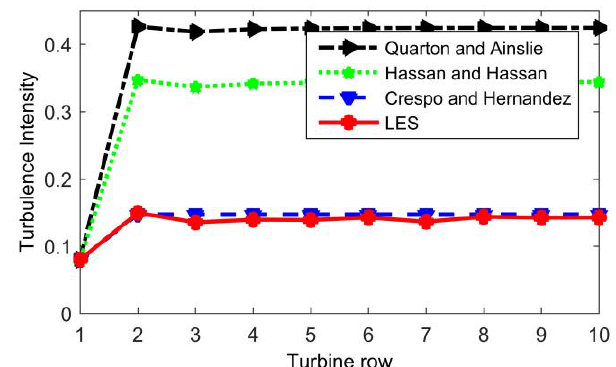
Figure 10. Comparison of the streamwise turbulence intensity at hub height immediately upstream of each turbine row, obtained with LES and three simple models.